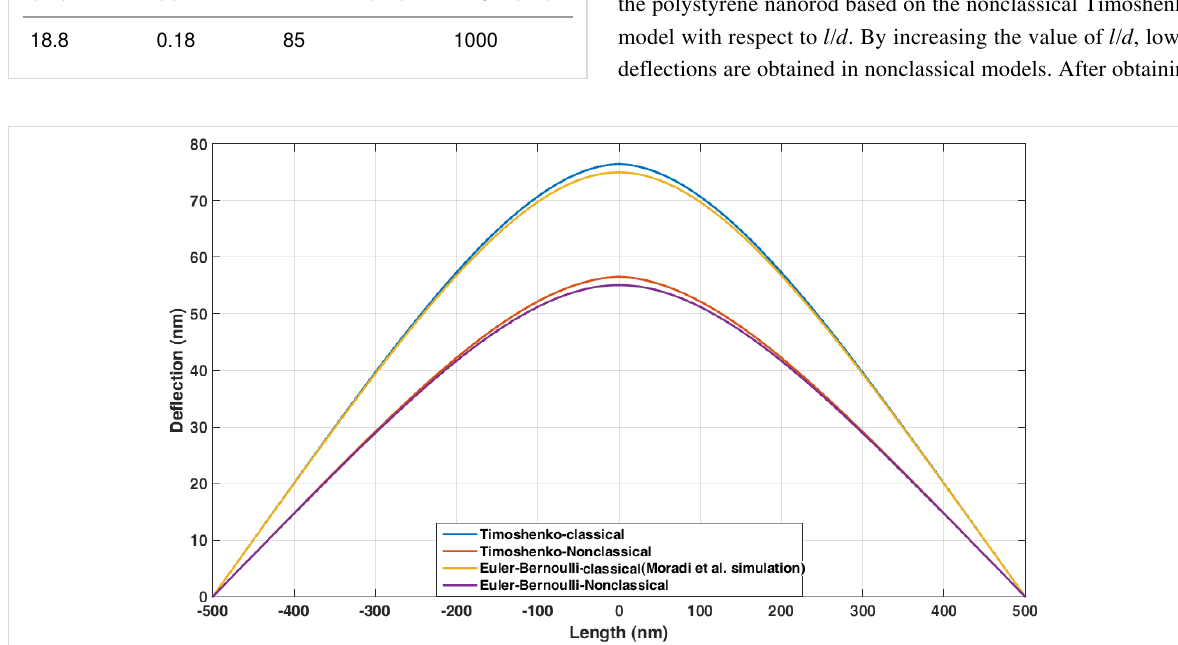
Figure 20 and Table 11 show the deflections of the polystyrene nanorod according to different models with the loading condi- tions presented in the study of Moradi et al.; the results are ob- tained by considering l / d = 0.25. As observed, nonclassical models predict 25% lower maximum deformation compared with the classical Euler–Bernoulli beam model as in the study of Moradi et al. By varying l / d , the deflections predicted in the nonclassical model change. Figure 21 and Table 12 show the deflections of the polystyrene nanorod based on the nonclassical Timoshenko model with respect to l / d . By increasing the value of l / d , lower deflections are obtained in nonclassical models. After